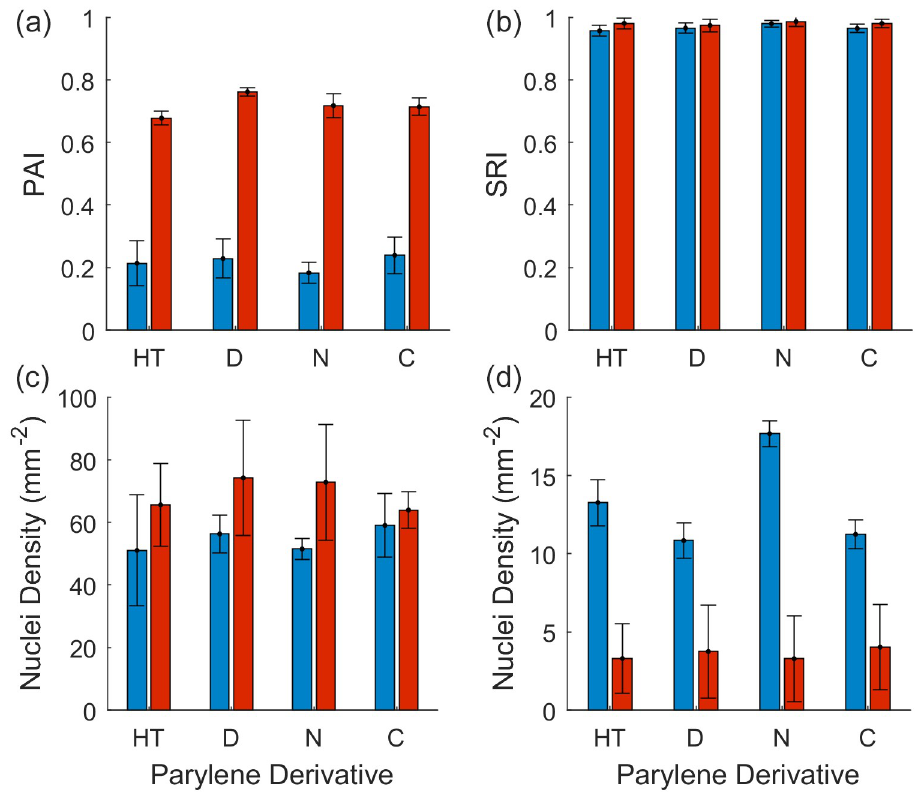
Fig 5. Influence of piranha acid treatment on the quality of cell patterning on parylene derivatives. Blue—No piranha acid treatment, Red—Piranha acid treated. (a) Parylene Adhesion Index. (b) Silicon Repulsion Index. (c) Nuclei density on parylene areas. (d) Nuclei density on SiO 2 areas. Error bars represent the standard error (n = 3). Statistics and p-values are listed in Table 1.